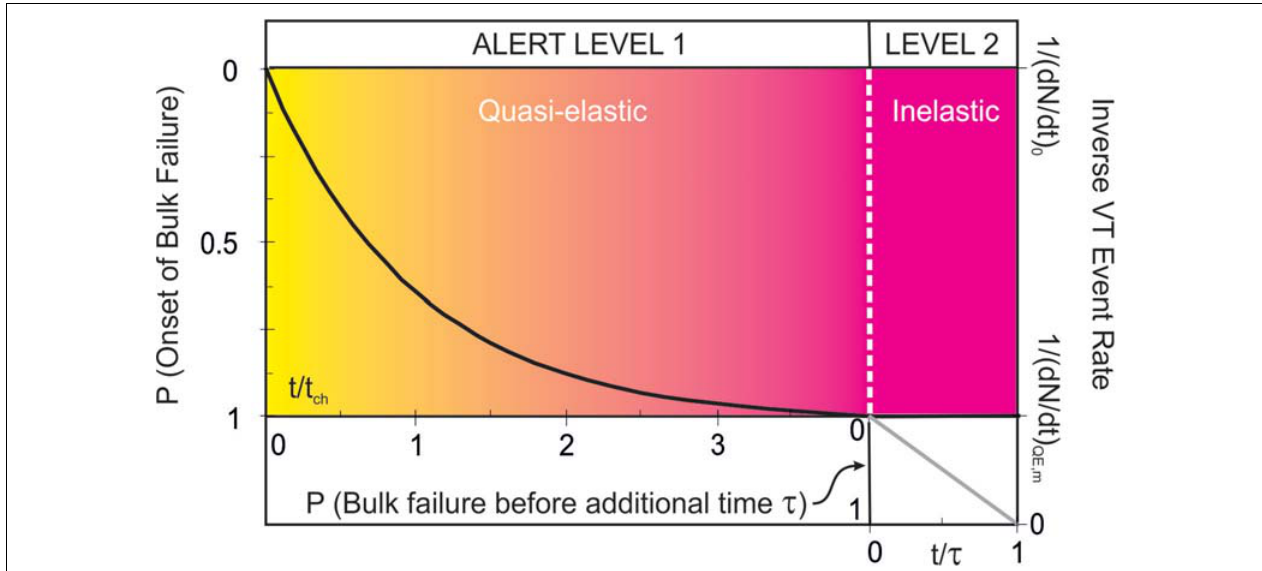
FIGURE 10 | The elastic-brittle trends can be transformed into probabilities of bulk failure and levels of alert. The example here assumes a steady rate of stress supply and an immediate transition from exponential to hyperbolic VT event rates after a time 4 t ch . Inverse trends are plotted because changes from an exponential to a linear decrease is easier to visualize that a change from exponential to hyperbolic increase. The transition from quasi-elastic to inelastic regime marks a step increase in alert level. Each level may itself consist of gradational changes, as implied by the colored gradient. The probability being quantified changes from the probability that bulk failure begins in the quasi-elastic regime to the probability that failure will be complete before the time interval τ in the inelastic